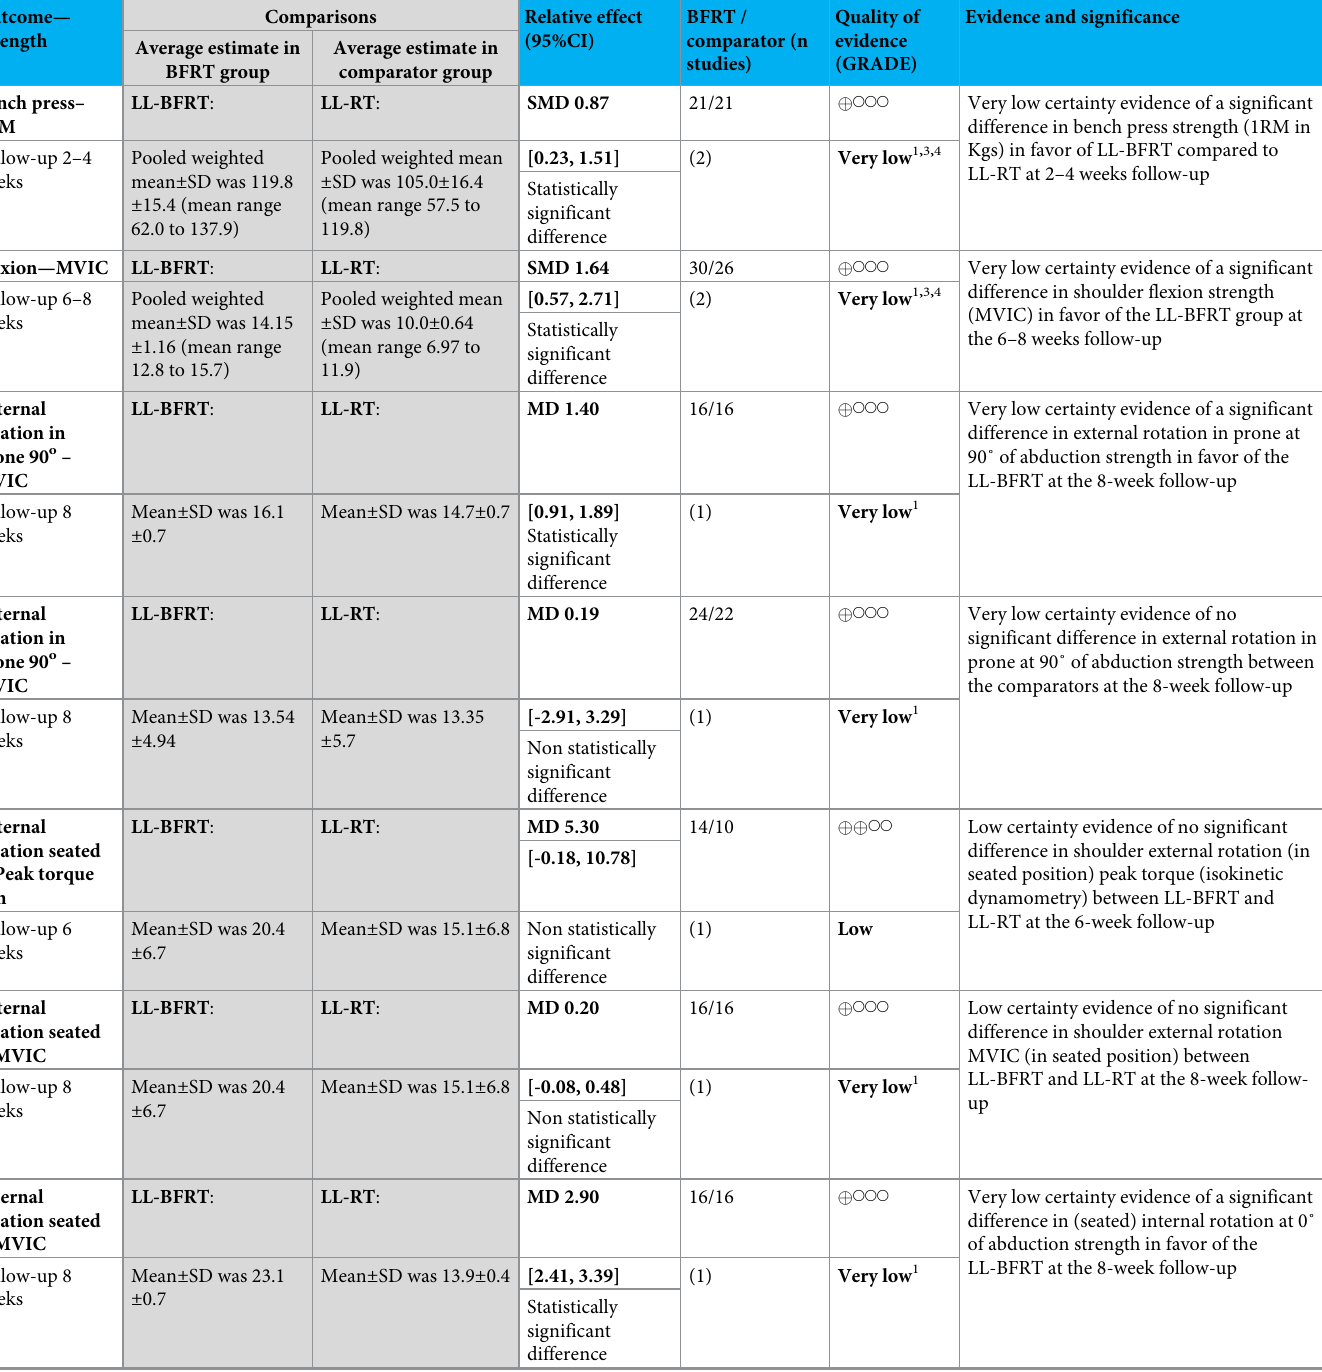
Table 4. Summary of evidence for the effects of LL-BFRT compared with LL-, HL-RT, or no exercise in muscle strength. Outcome—